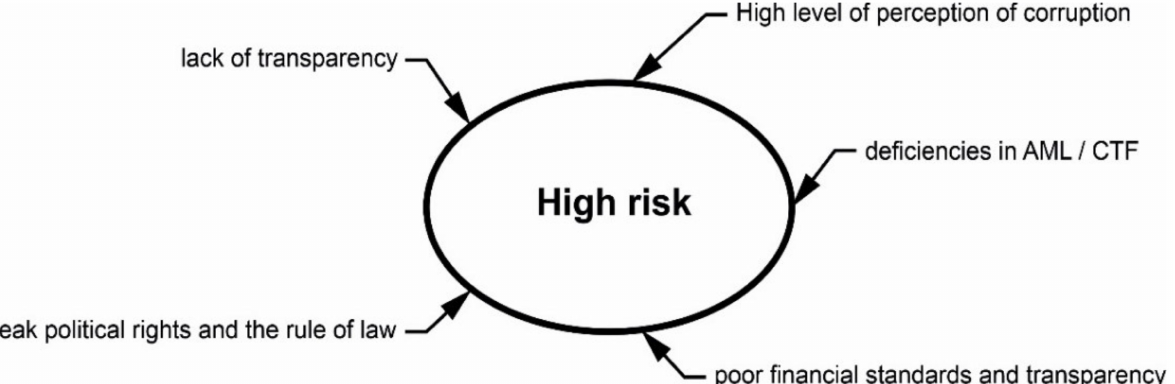
Figure 1. Factors contributing to the high ML/TF risk score. Source: Compiled by the